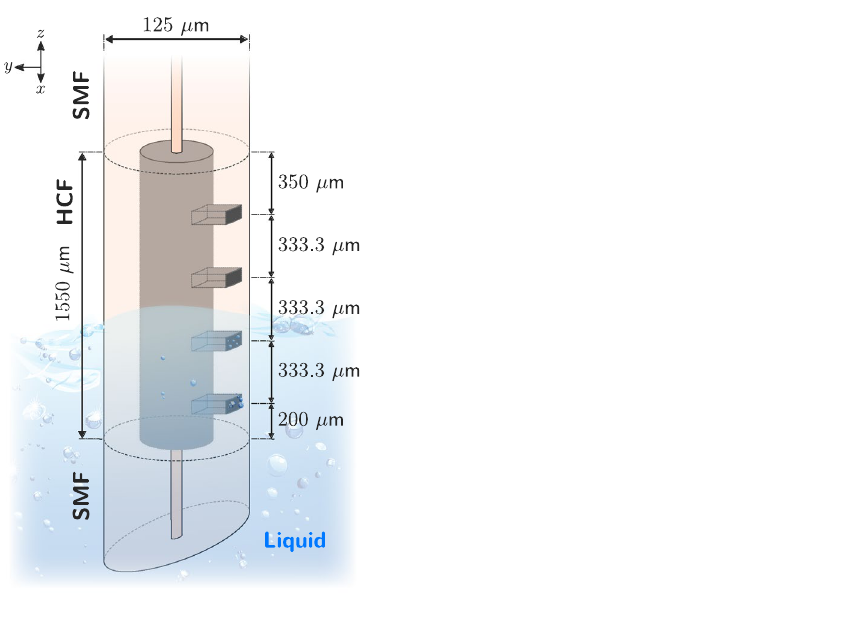
Figure 1. Schematic view of the manufactured sensor. It is based on a 1.55 mm long HCF with four holes fabricated by femtosecond laser ablation. This structure behaves as a liquid level sensor through the dynamic variation of the Fabry–Perot cavity length that forms the liquid within the fiber.